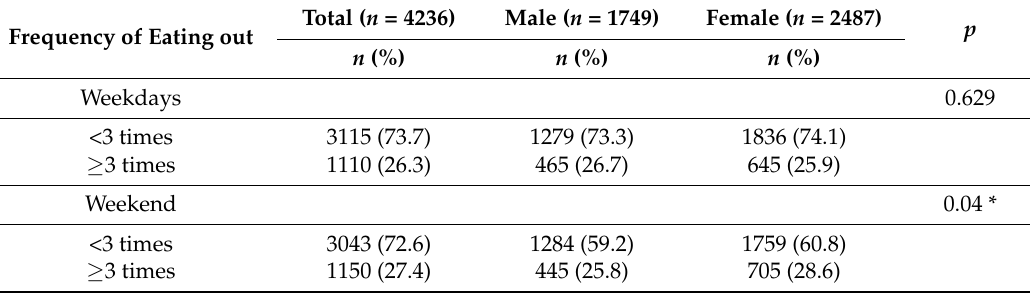
Table 2. Frequency of eating out per week for the last month by sex ( n =